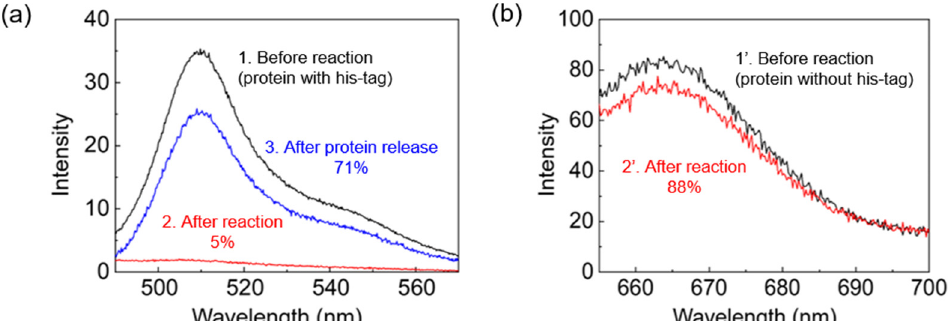
Figure 4. ( a ) Fluorescence spectra for the solutions of histidine-tagged GFP (1) before and (2) after the treatment with Ni/NiO nanoparticles and (3) after the treatment of protein-bound Ni/NiO nanoparticles with imidazole solution. ( b ) Fluorescence spectra for the solutions of normal mouse IgG1 labeled with Cy5 (1 ′ ) before and (2 ′ ) after the treatment with Ni/NiO nanoparticles.